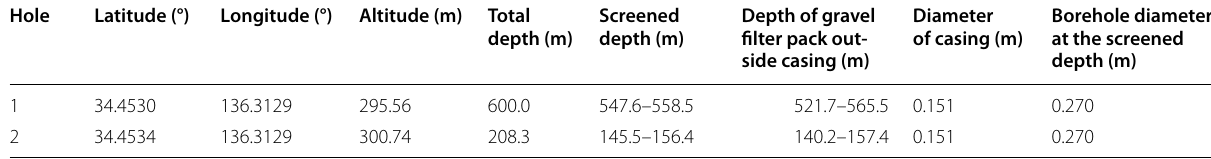
Table 1 Locations and specifications for Holes 1 and 2 at the ITA observatory Hole Latitude